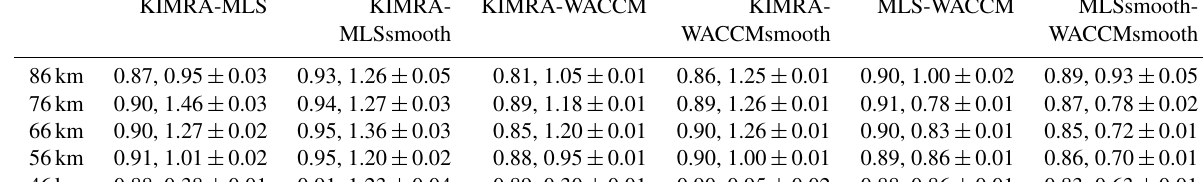
Table 2. “Correlation coefficient, regression coefficient ± error” for comparisons of daily CO VMRs from KIMRA, MLS, and SD-WACCM above Kiruna for 2008 through 2014. The abscissa variable is the first-named of each instrument pairing. A regression coefficient >1 (<1) indicates a larger (smaller) range in the abscissa variable. Figure 1 shows the time series of each CO VMR dataset. See Sect. 2.4 for details.